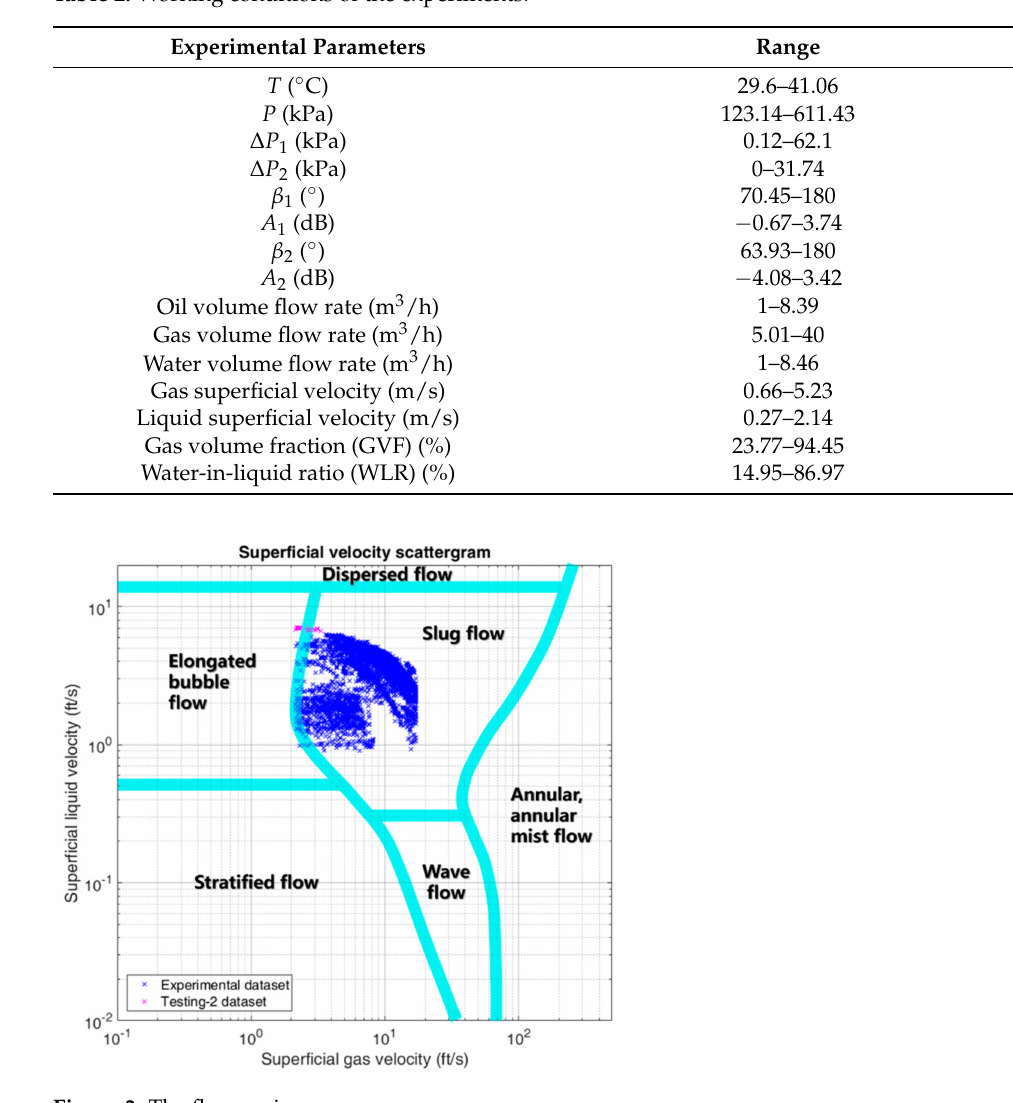
Figure 3. The flow regime